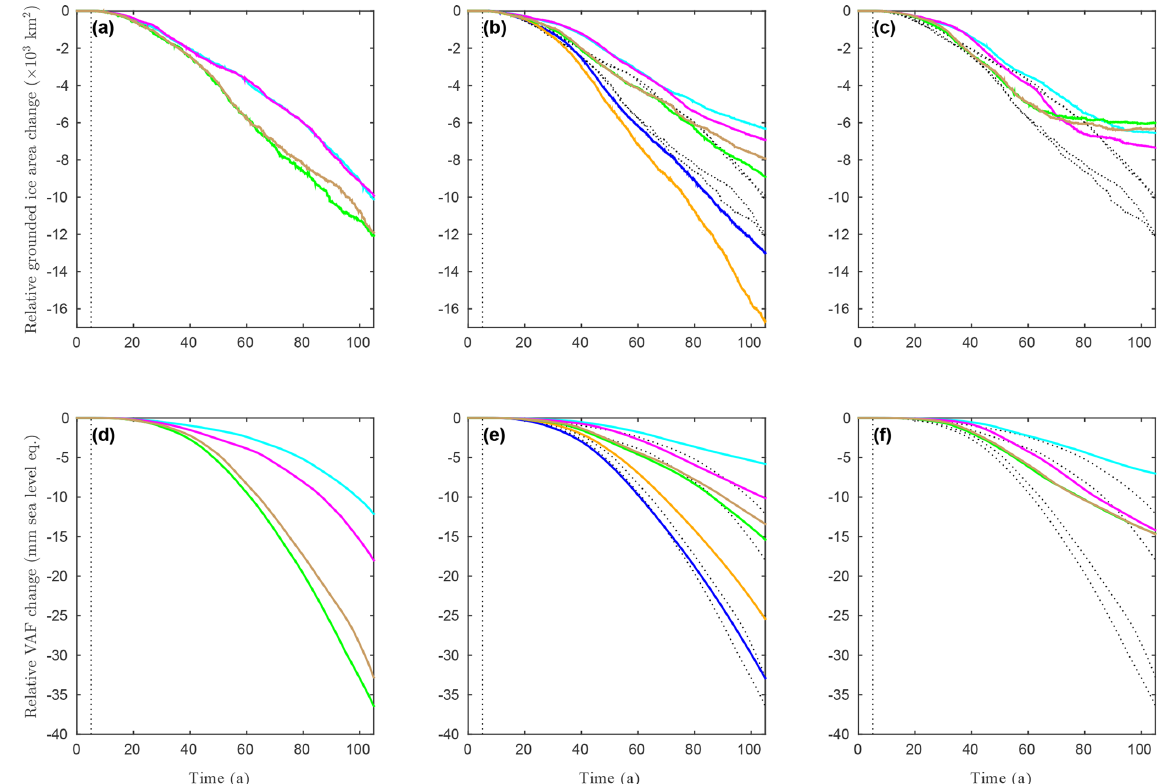
Figure 7. Evolution of grounded ice area in × 10 3 km 2 (first row) and of volume above flotation in millimetre sea-level equivalent (second row) as a function of time during EXP_ABMB (coloured solid lines) relative to EXP_CONTROL for the inferred states I R and (d) , I R – panels (b) and (e) , and I R – panels (c) and (f) – with the friction laws, linear Weertman (cyan), non-linear Weertman γ, 100 γ, 1 (magenta), Schoof with C max = 0 . 4 (green), Schoof with C max = 0 . 6 (brown), linear Budd (orange, for the inferred state I R non-linear Budd (blue, for the inferred state I R only). The results obtained with the various friction laws for the inferred state I R γ, 100 reported on, respectively, (b–c) and (e–f) for ease of comparison (black dotted lines). The vertical black dotted lines mark the introduction of the perturbation at t = 5a.